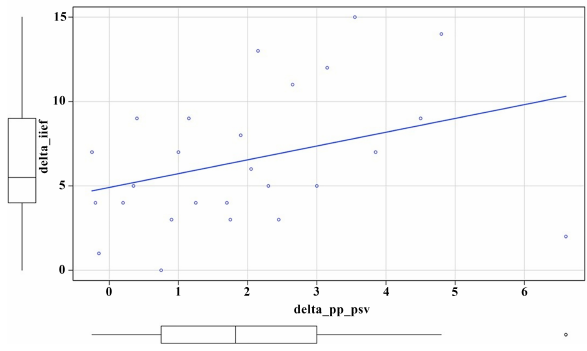
Fig. 1. Correlation of delta PSV and